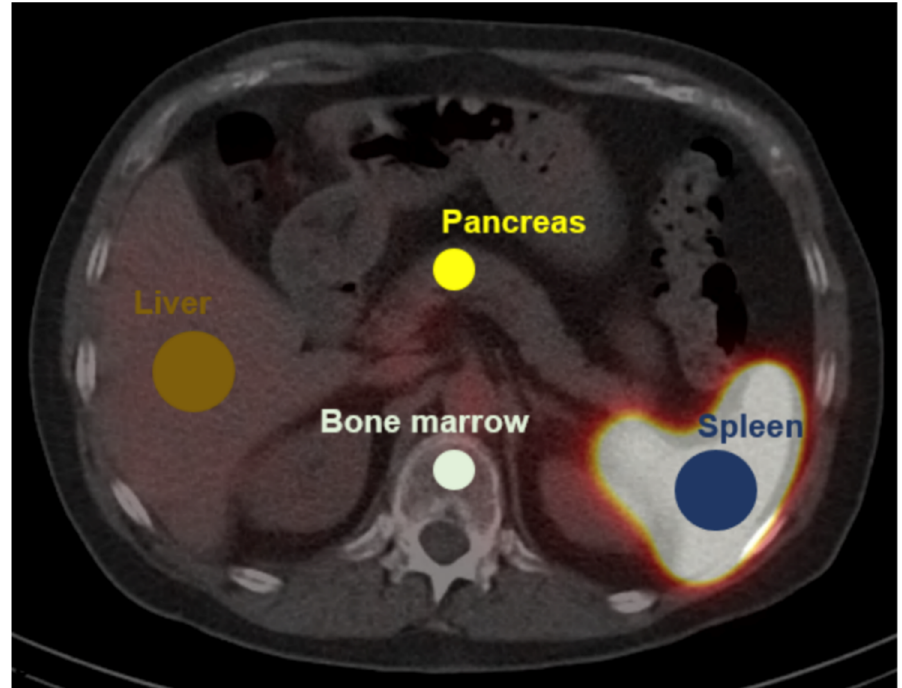
Figure 1. VOI definition for quantification of physiologic uptake. 99m Tc-labelled denatured red blood cells single photon emission tomography (SPECT) is fused on low dose computed tomography (CT). Diameter of spherical 3D-VOIs: pancreas 1.5 cm, bone marrow 1.5 cm, spleen 3.0 cm, liver 3.0 cm.